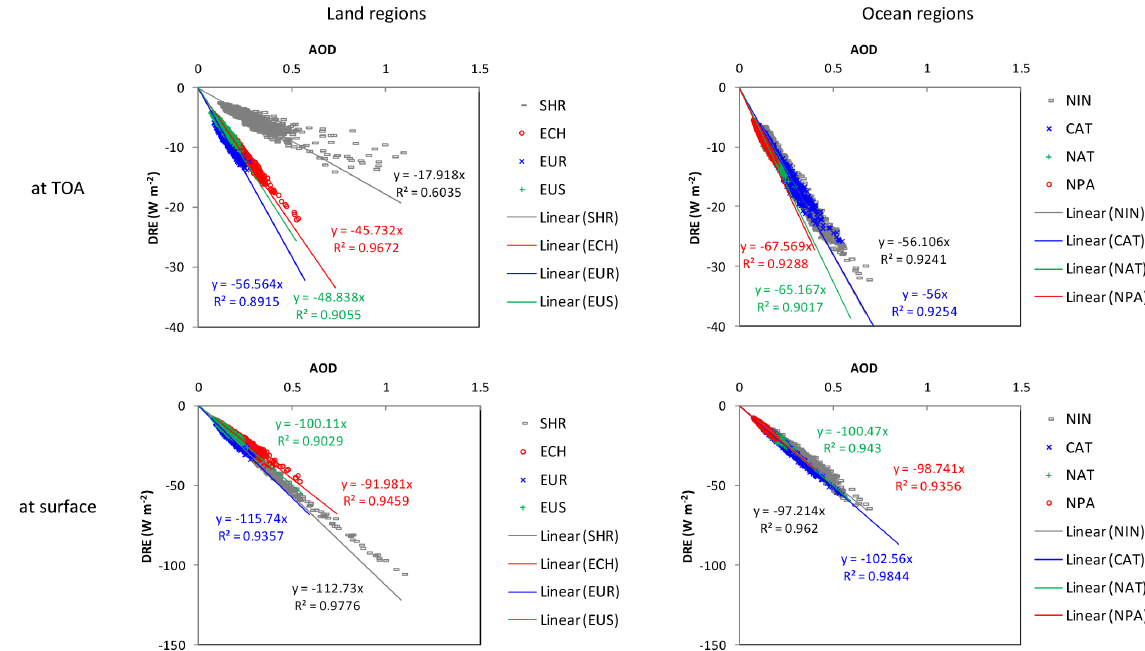
Figure 10. Daily daytime clear-sky DRE against AOD (local time 06:00–20:00 averaged regionally and temporally over